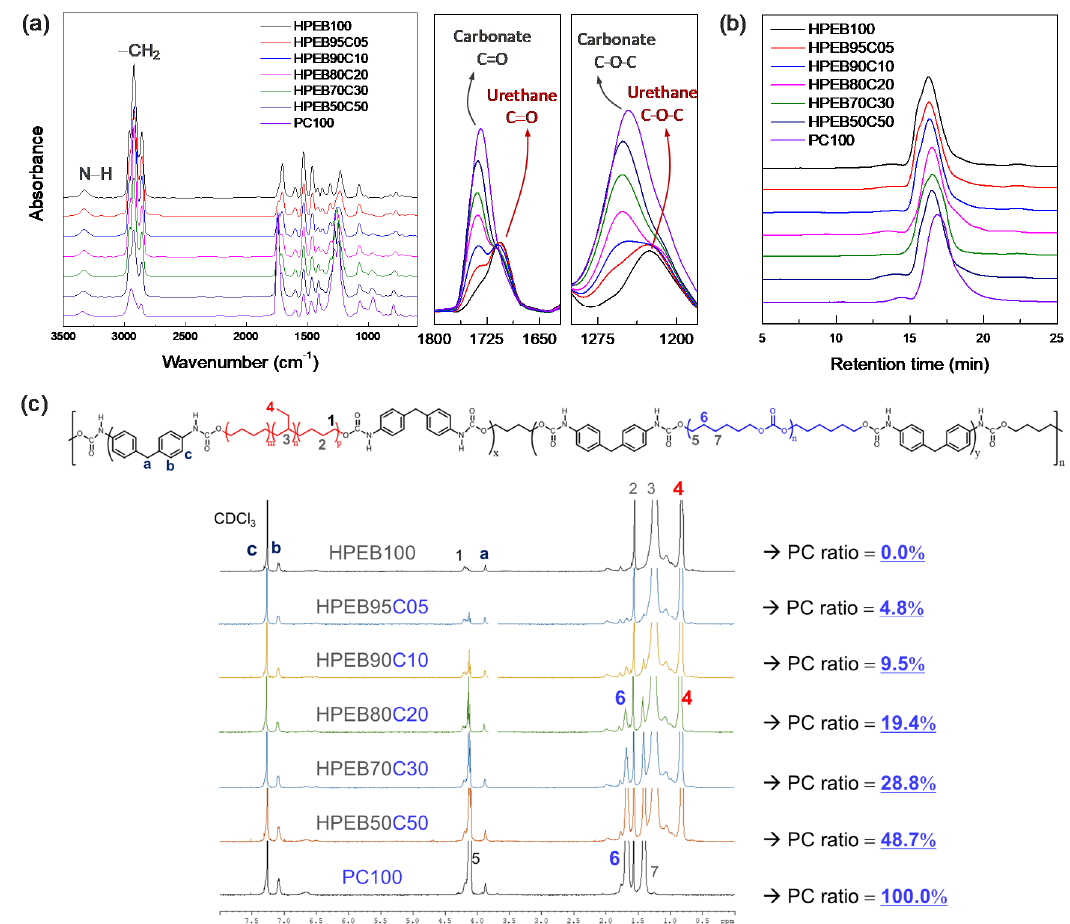
Figure 2. ( a ) FT-IR spectra, ( b ) GPC plots and ( c ) 1 H-NMR spectra of the polyurethane copolymers.